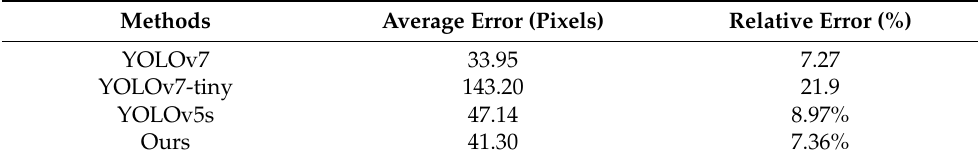
Table 5. The Compared results on internode length estimation.